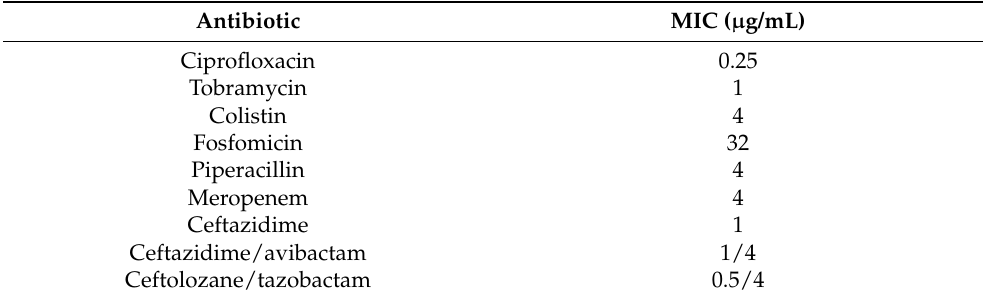
Table 2. Susceptibility (MIC values) of P. aeruginosa PAEG1 against nine antibiotics/antibiotic combinations.